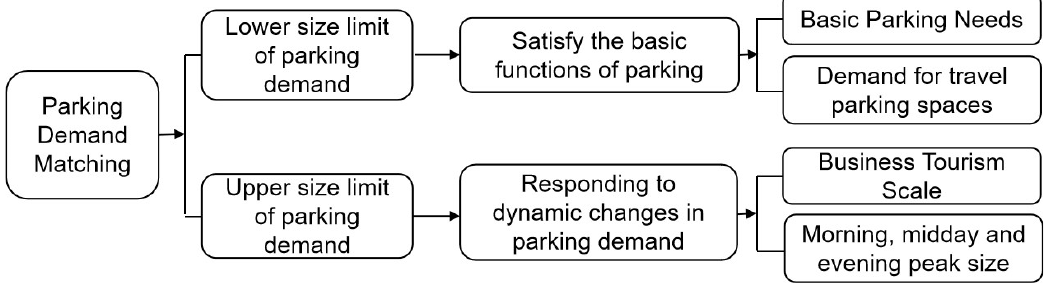
Figure 17. Parking facility demand forecasting methodology.